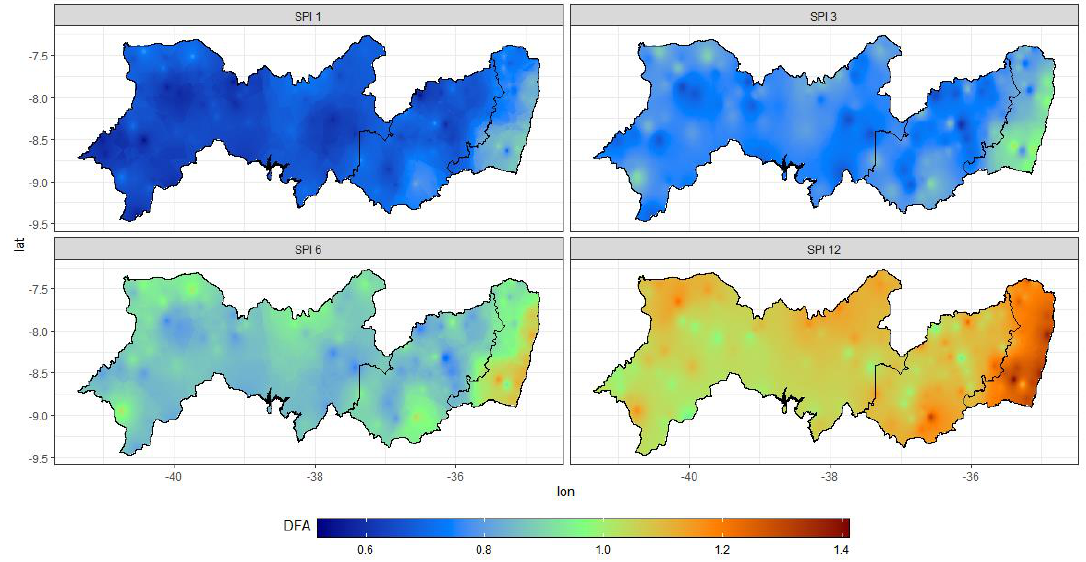
Figure 8. Spatial distributions of detrended fluctuation analysis (DFA) exponents 𝛼 for SPI at different time scales (SPI-1, SPI-3, SPI-6 and SPI-12) across Pernambuco state.